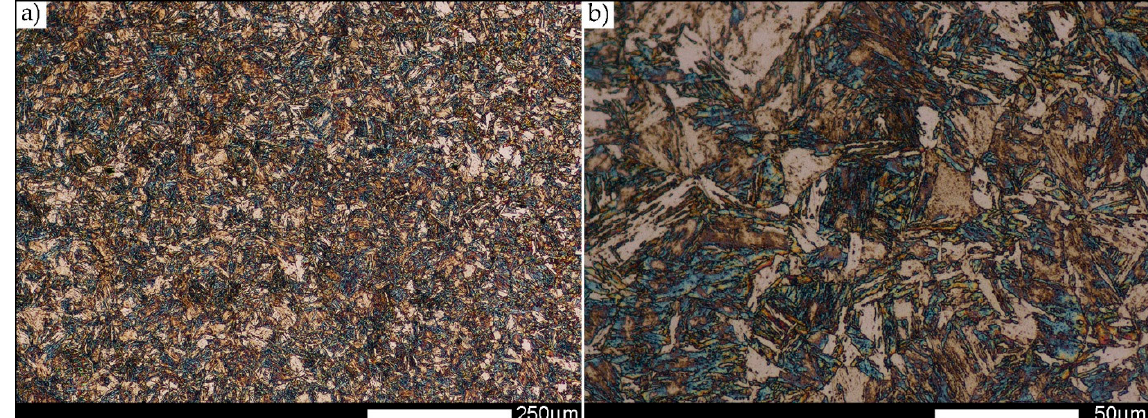
Figure 5. Microstructure of a welded joint of Hardox 450 steel in delivery state (directly after welding)—BM area shown in Figure 2a. ( a ) 100×; ( b ) 500×. Microstructure of low carbon quenching martensite with areas of tempering martensite. Light microscopy, etched with 3% HNO 3 .